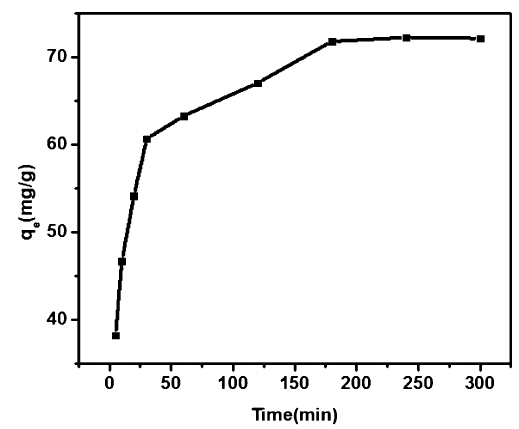
Fig. 7 Effects of contact time on the adsorption amount of AM on